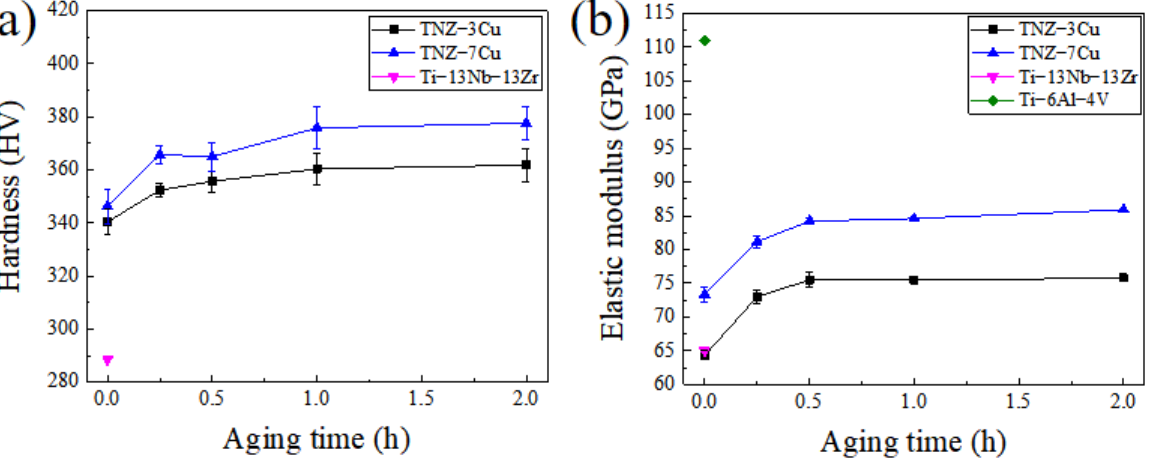
Figure 7. ( a ) Micro-vickers hardness and ( b ) elastic modulus of TNZ-xCu (wt.%, x = 3, 7), and TNZ and Ti-6Al-4V alloys at different aging treatment conditions.